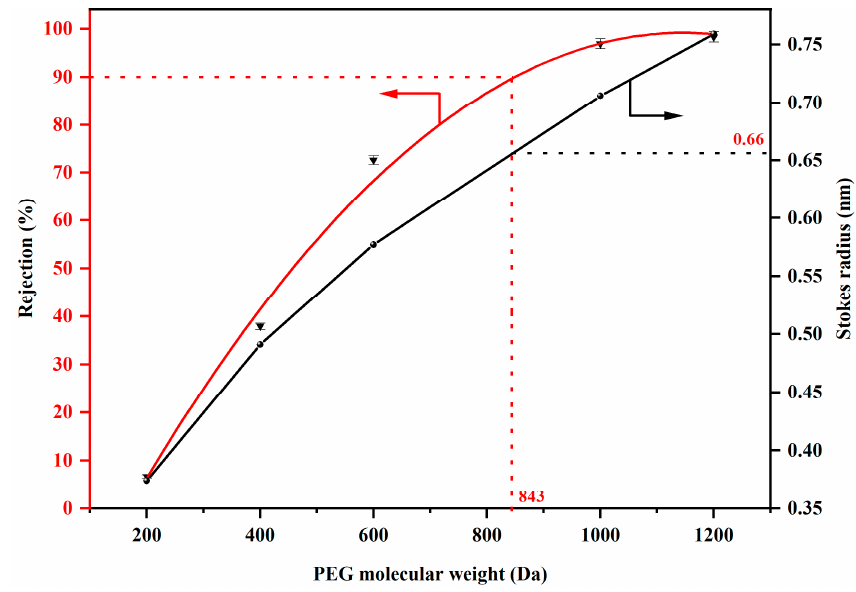
Figure 10. The MWCO of PES–DPS–1 membrane (the PEG concentration was 0.2 g·L − 1 ).